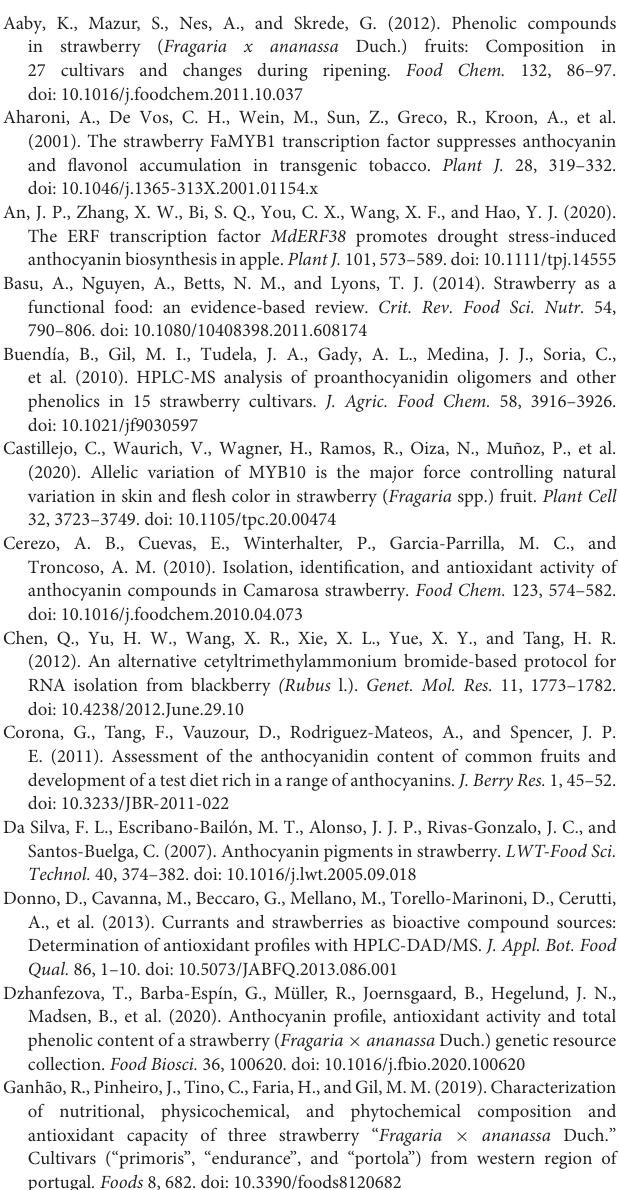
Supplementary Table S3 | FPKM values of flavonoid biosynthetic genes. Supplementary Table S4 | List of differentially expressed transcription factors. Supplementary Table S5 | Correlation pairs of genes and metabolites, transcription factors and genes.